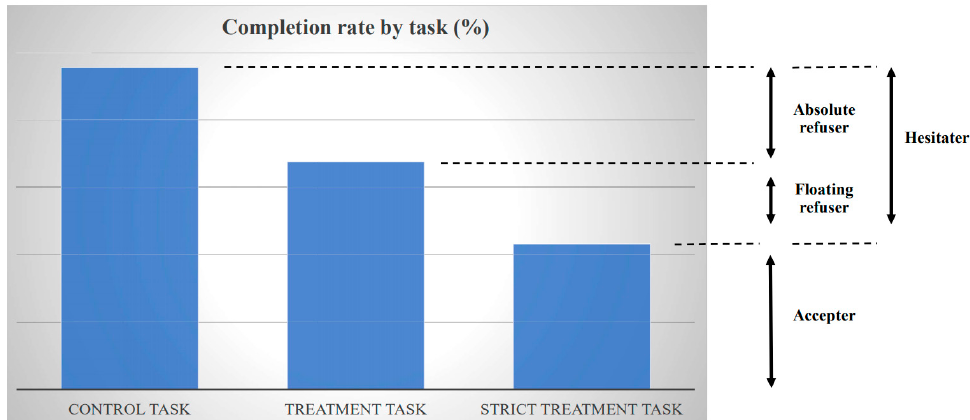
Figure 4. Interpretation of experiment. Notes: “Control Task” is the completion of the follow-up survey. “Treatment Task” is the completion of the follow-up survey and vaccination in the treatment group. “Strict Treatment Task” is the completion of the follow-up survey, vaccination, and the submission of the voucher in the treatment group. WTP < 0 among absolute refusers, and WTP ≅ 0 (or weakly positive) among floating refusers.